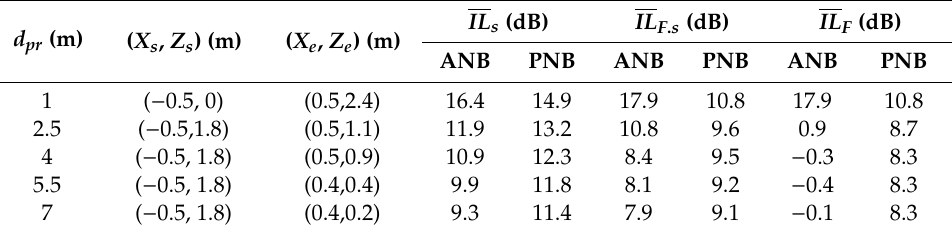
Table 1. Best positions for the transducers and the insertion loss achieved when the street area is the target zone. d pr is the distance of the noise source from the barrier and IL s , IL F . s , and IL F are the average insertion loss in the street area, in the shadow zone of the façade, and in the whole building, respectively. The insertion loss with the passive noise barrier (PNB), is the di ff erence of the average sound pressure level in the observational points with and without barrier, and the insertion loss of the active noise barrier (ANB) is computed by Equation (9). ( X s , Z s ), ( X e , Z e ) are the coordinates of the control sources and error sensors,